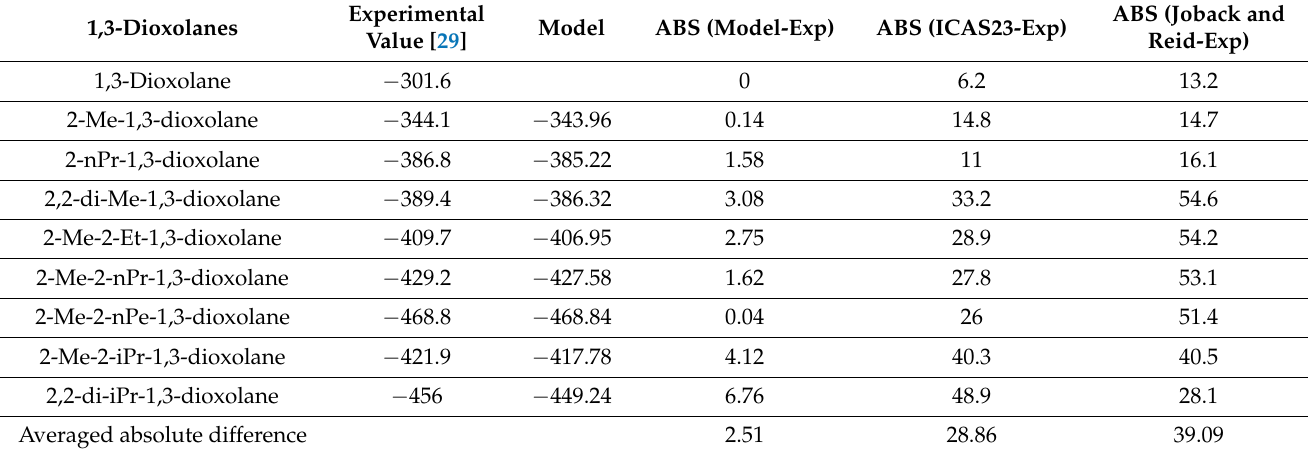
Table 6. Experimental and model values for the gas phase heat of formation for a set of 1,3-dioxolanes. All values in kJ/mol. 1,3-Dioxolane was adopted as individual groups with a group-contribution- specific parameter value that was its experimental value. Consequently, the value “model-exp.” is given as